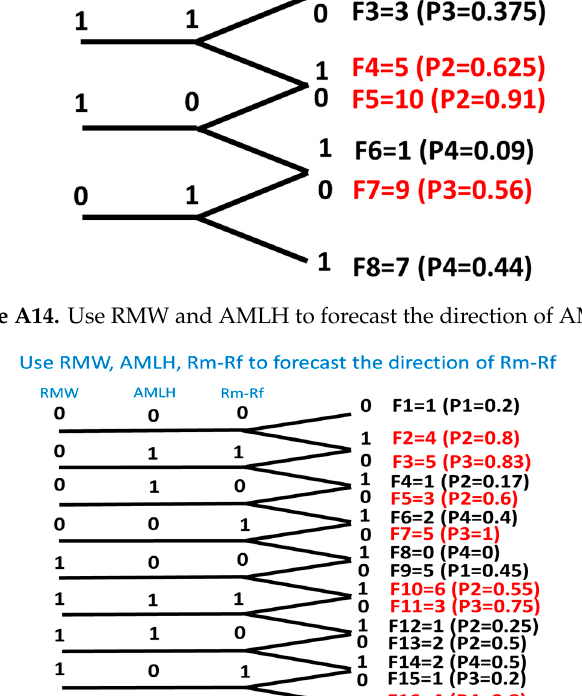
Figure A15. Use RMW, AMLH, and Rm-Rf to forecast the direction of Rm-Rf.